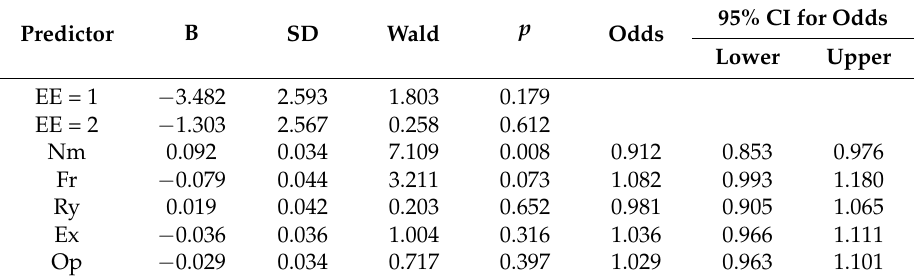
Table 3. Ordinal logistic regression for the emotional exhaustion